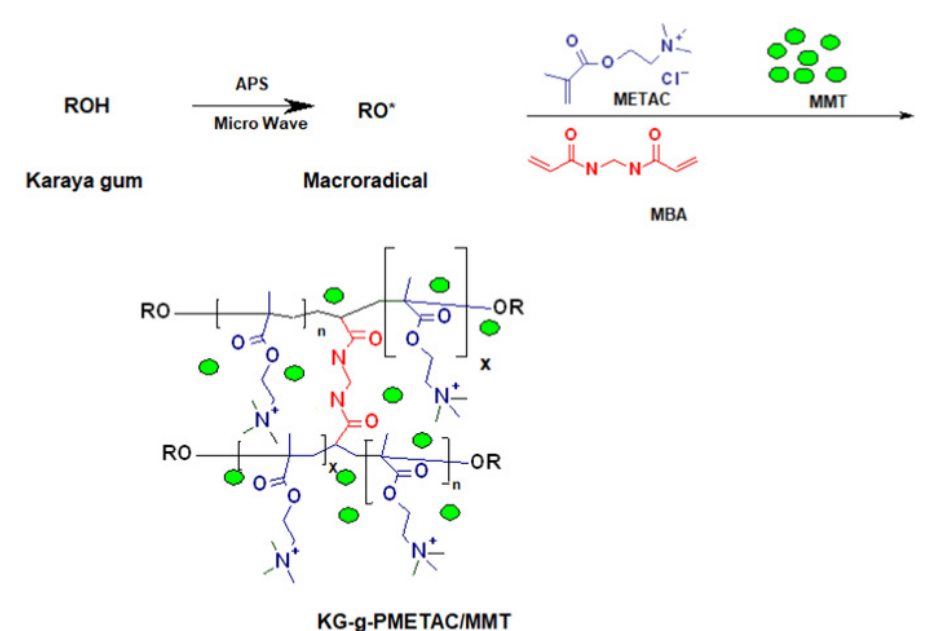
Figure 9. Formation process of KG-g-PMETAC/MMT composite adsorbent [198].